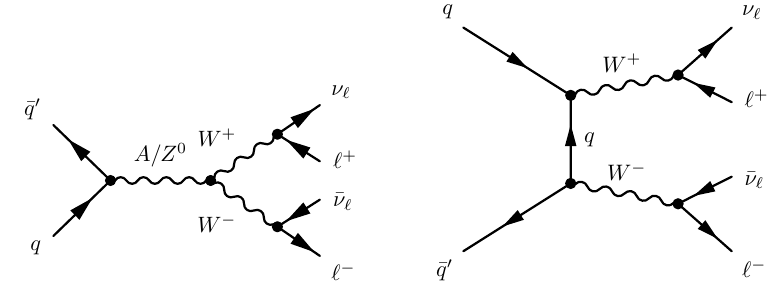
Figure 6. W + W − background topologies. All particles shown here are purely SM ones. The final leptonic channels in both the signal events and the W + W − background processes shown here are chosen to be